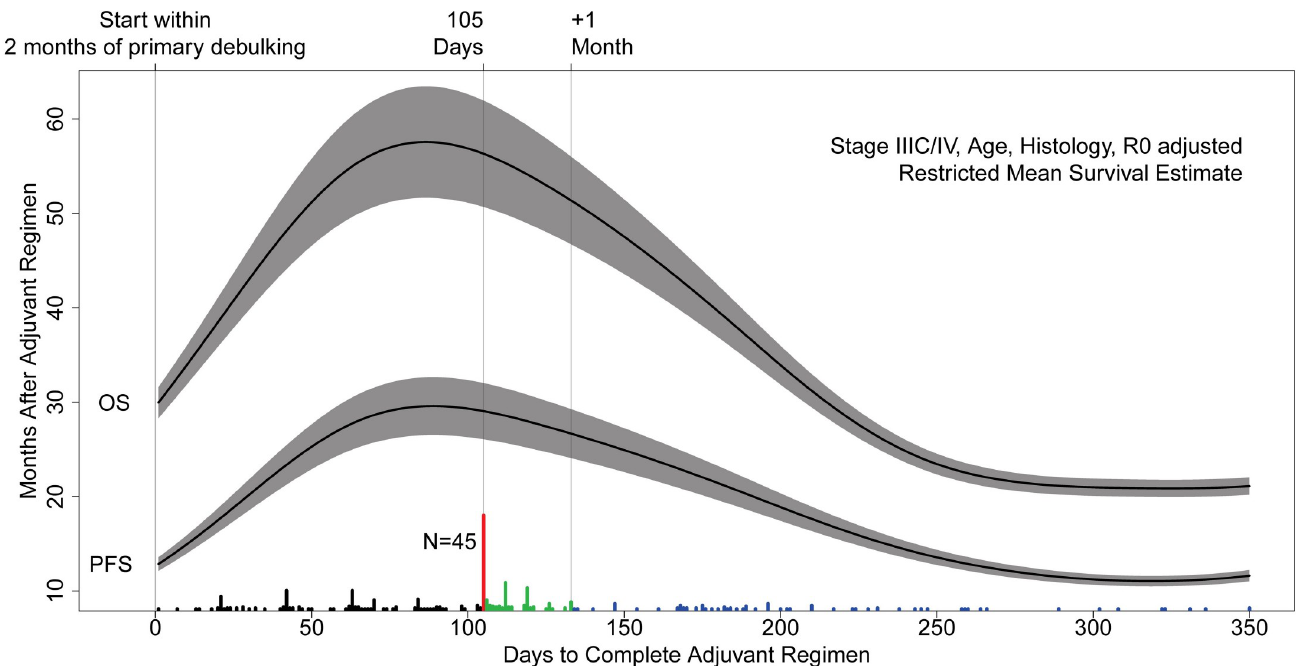
Fig 3. Continuous time-to-completion functional analysis of length of chemotherapy regimen and survival.